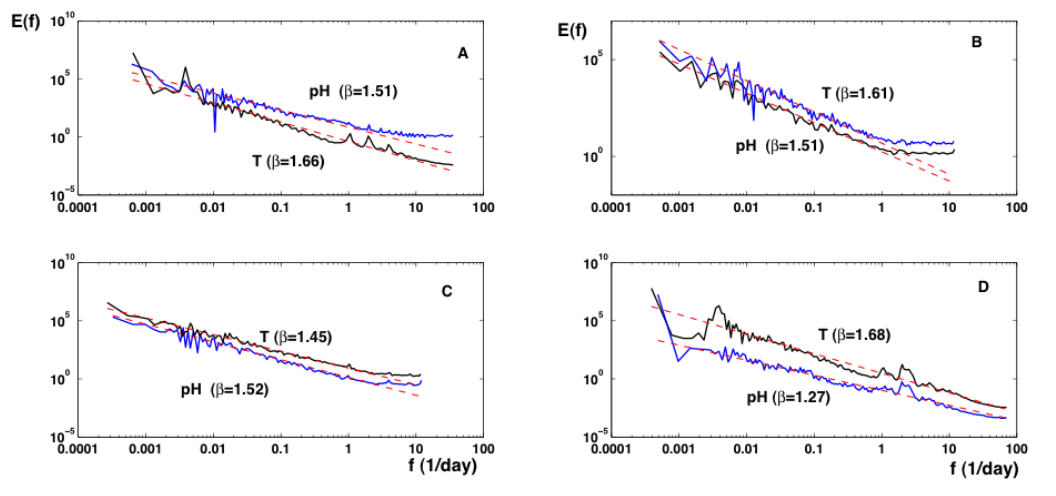
Fig. 7. pH and temperature spectra: (A) Carnot; (B) Grande rade; (C) La Carosse and (D) Honfleur. This indicates scaling regimes, with different spectral slopes, between 1.27 and 1.68.